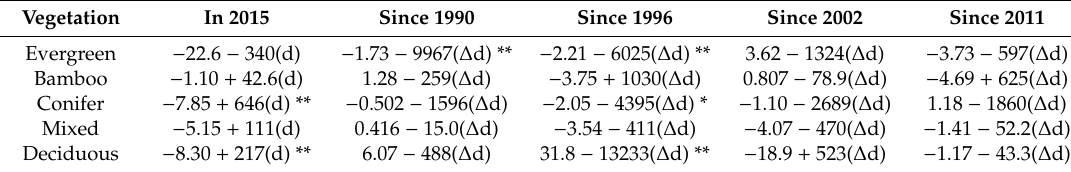
Table 4. Log-odds of reporting crop raiding as “serious” or “very serious” in the 2015 survey based on interpolated boar density (“In 2015”); log-odds of reporting crop raiding as becoming less severe in the past 10 years based on estimated changes in boar density between a given year and 2016 (“Since [year]”). Vegetation In 2015 Since 1990 Since 1996 Since 2002 Since